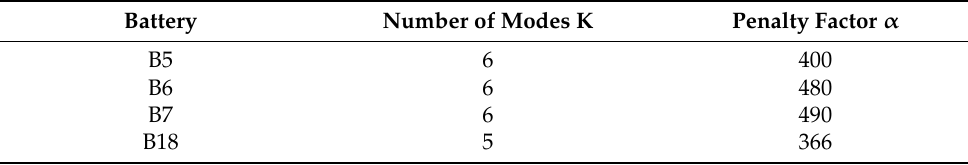
Table 1. Optimal parameter of